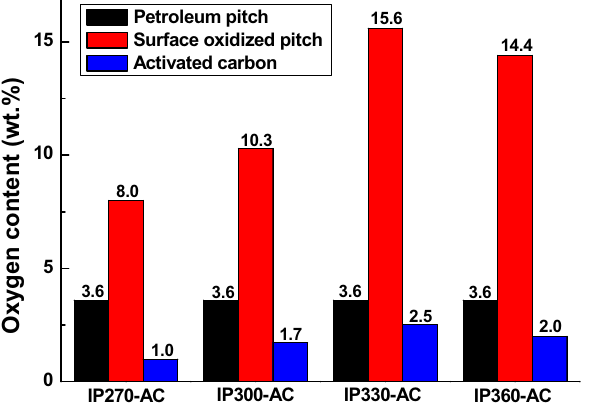
Figure 5. Oxygen contents of surface oxidized pitches and activated carbons from petroleum